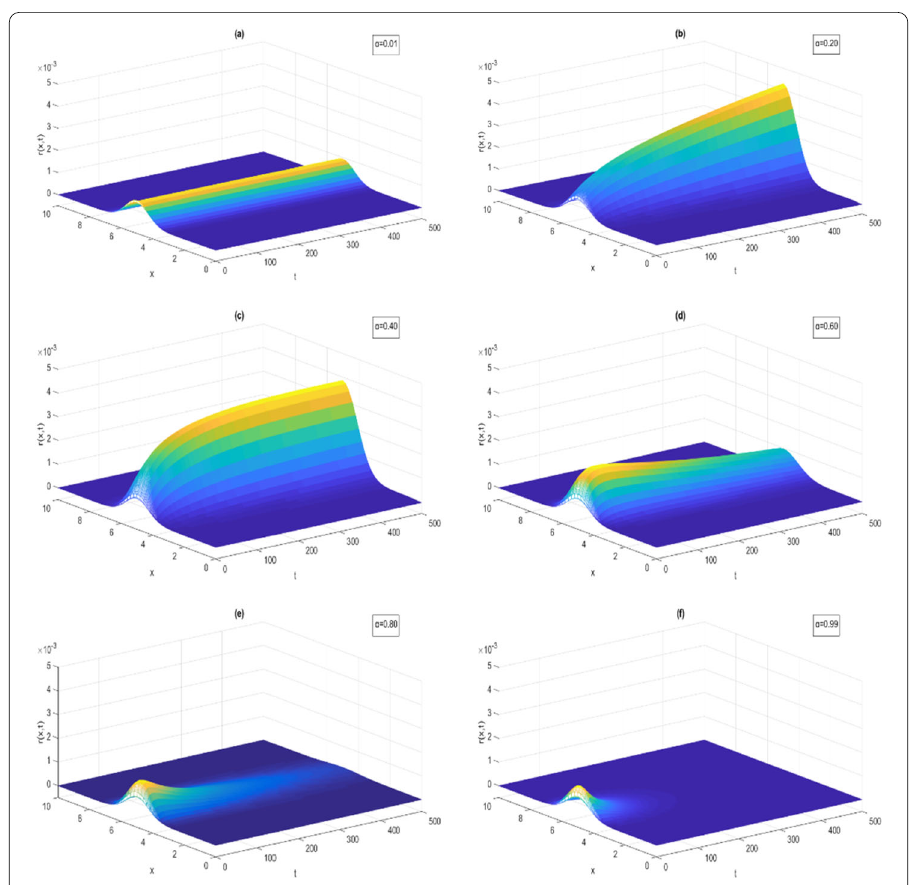
Figure 5 The approximation solutions of the fractional order differential equation for λ = 0.332, a = 1, b = 1, β 2 = 2, k = 2, m = 1, D = 0.01, β 1 =